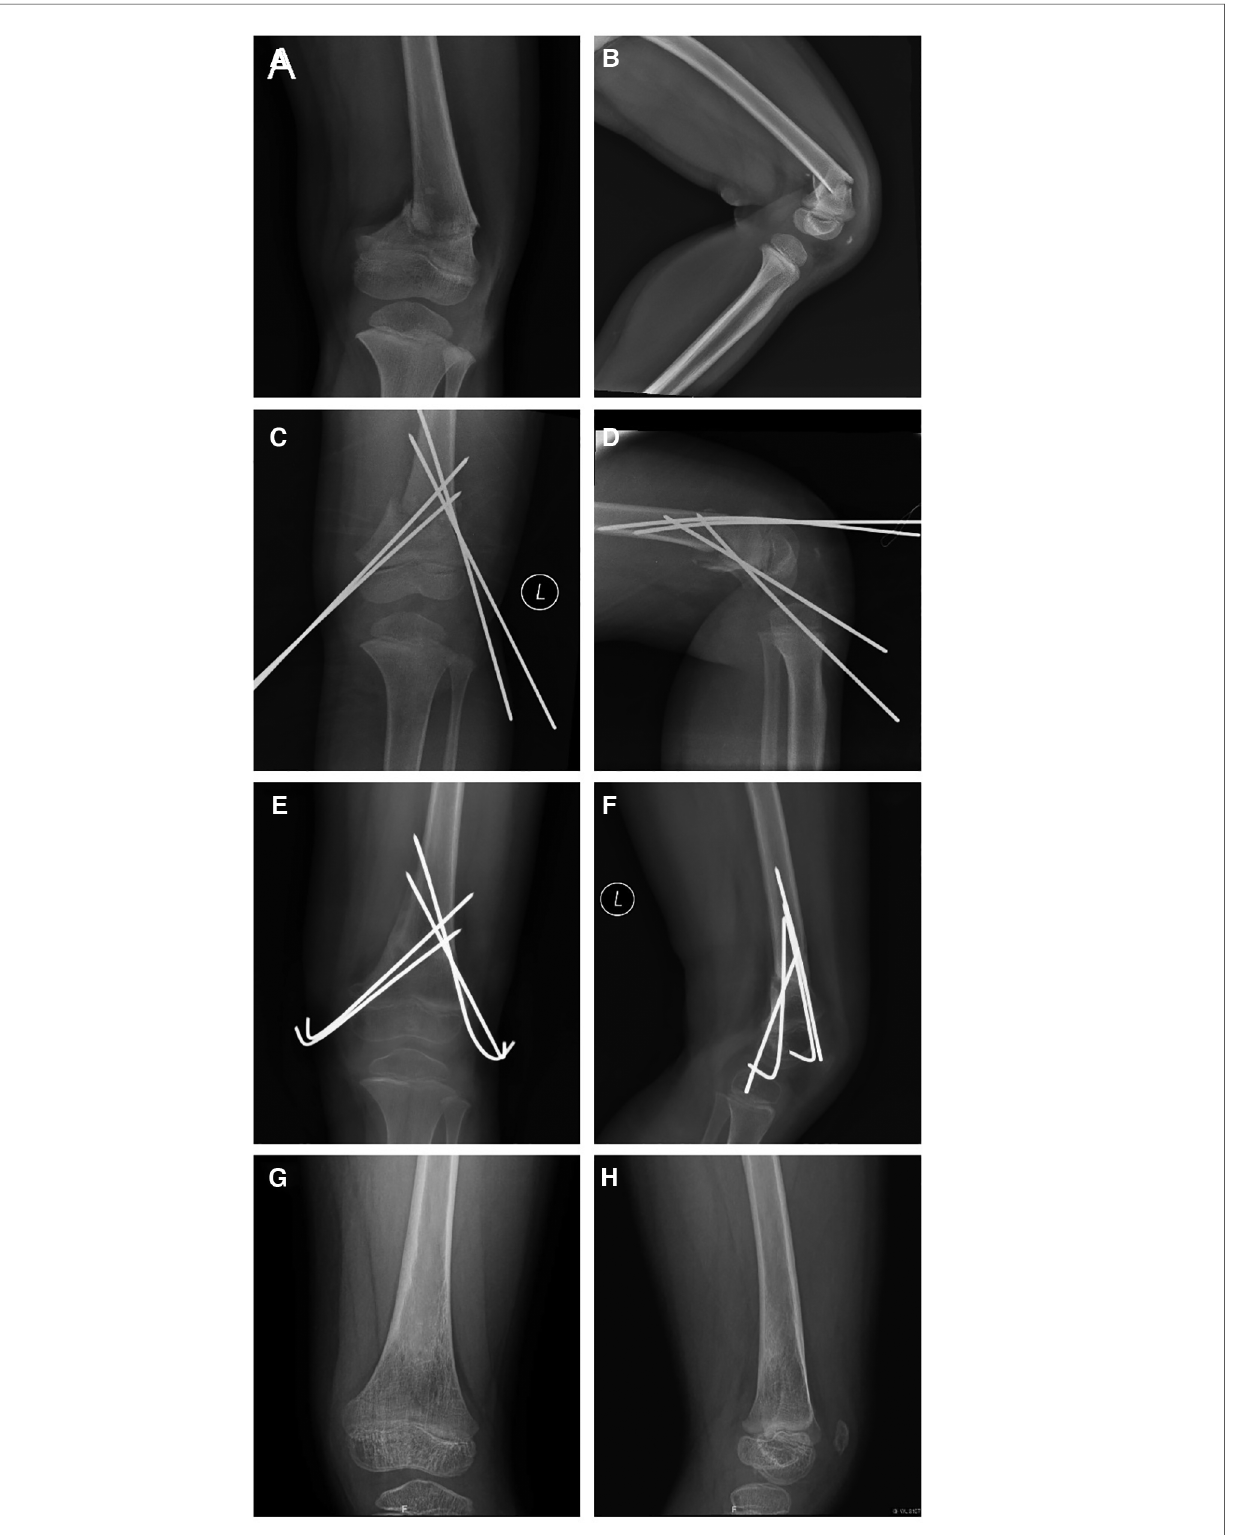
FIGURE 1 Outcome in a 4-year-old girl with a displaced supracondylar femoral fracture. Anteroposterior ( A ) and lateral radiographs ( B ) obtained before surgery. Intraoperative anteroposterior ( C ) and lateral radiographs ( D ). Anteroposterior ( E ) and lateral radiographs ( F ) obtained 1 month after surgery, and showing the fracture has healed. Anteroposterior ( G ) and lateral radiographs ( H ) obtained 1 year after surgery, which showed limb alignment was normal and epiphyseal development was